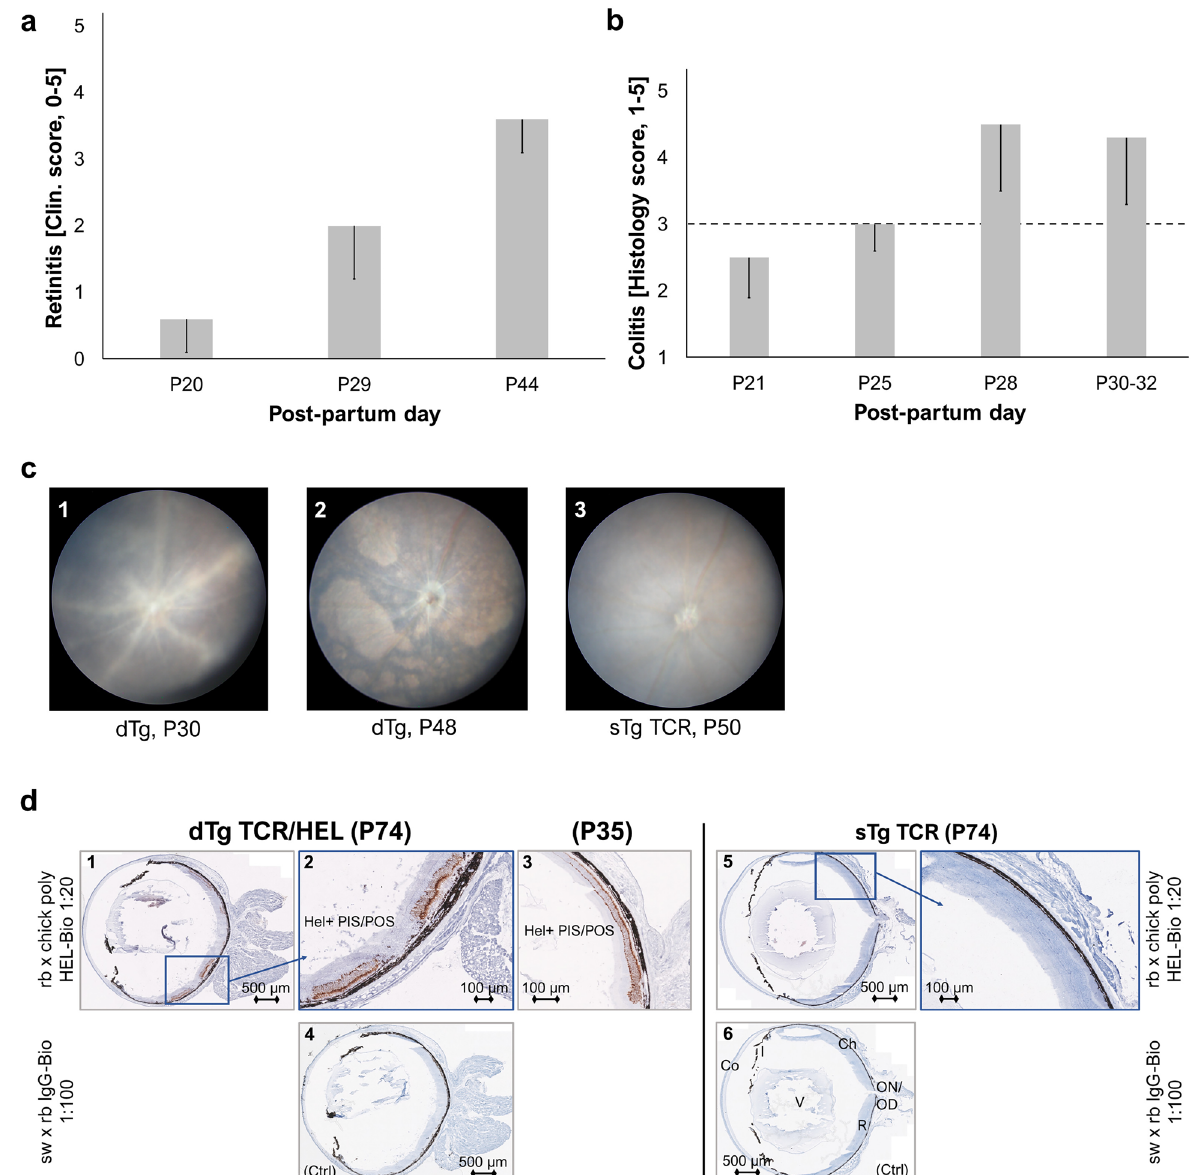
Figure 2. Colitis and retinitis (spontaneous EAU) have distinct clinical onsets. ( a ) Mice with EAU (n = 7–8, assessed independently) spontaneously develop uveitis from P20 with gradual worsening of inflammation until P44 when the disease wears off leaving behind irreversible retinal atrophy. ( b ) Clinical signs of colitis (i.e., diarrhoea, rectal prolapse) were observed in dTg mice (n = 4 per age-group, independently assessed) from around P30. Histological staining and subsequent scoring revealed the presence of colon inflammation after P25 (clinical scores between 1 and 3 were identified as the baseline range, dashed line). Error bars indicate sd. ( c ) Representative fundoscopy images of P30 dTg (1, vasculitis), P48 dTg (2, retinal atrophy), and P50 TCR eyes (3, normal retina) (n = 34 eye pairs/genotype group; independently assessed. ( d ) Eye sections of dTg aged mice (P74; n = 3, independently stained, three replicates) show transgenic expression of HEL protein in their photoreceptor layer (1, 2; brown staining). This is specific to this spontaneous EAU mouse model in which HEL is the uveitogenic antigen 17 . Photoreceptor structure is better preserved in younger eyes (3). Note the absence of staining in control section (ctrl; 4) as well as sTg TCR eyes that are devoid of the retinal transgene (5, 6). Abbreviations: PIS/POS, photoreceptor layer inner and outer segment; Ch, choroid; R, retina; ON/OD, optic nerve/disc; V, vitreous; Co,